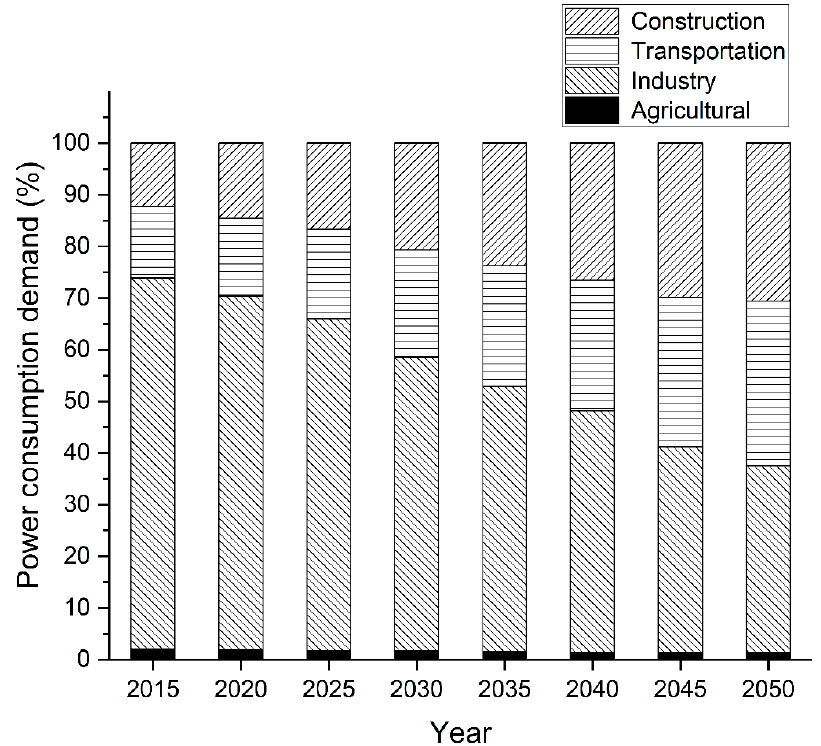
Figure 3. Proportion of power demand in terminal departments. Table 3. Growth rate of power demand in terminal departments